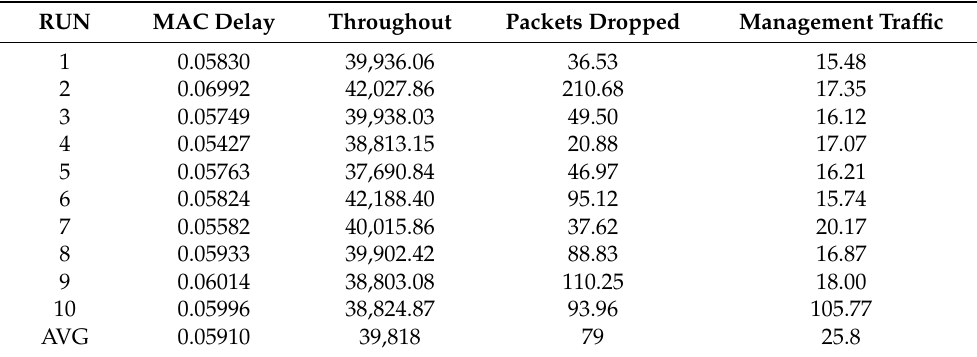
Table 12. Patient Bed Scenario Tabu